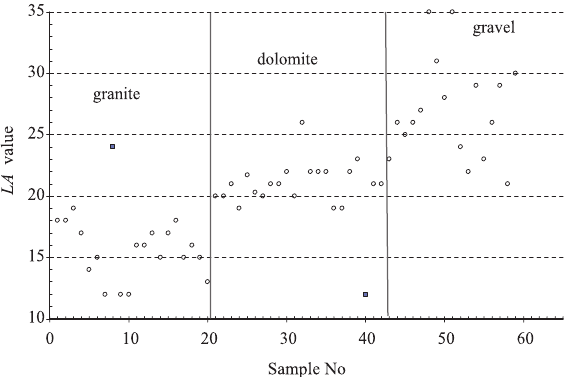
Fig. 2. LA values of resistance to fragmentation of